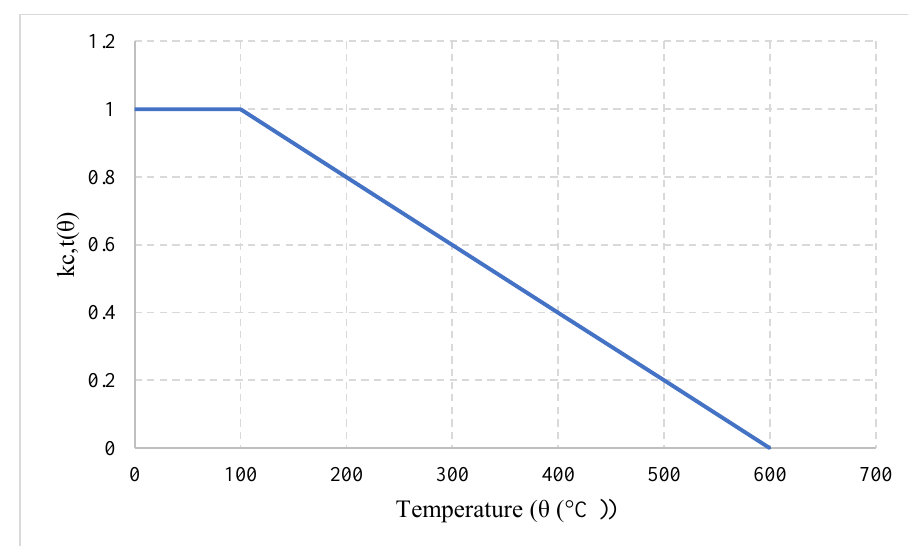
Figure 46. Coefficient k c,t (θ) allowing for decrease in tensile strength (f ck ,t) of concrete at elevated temperatures.